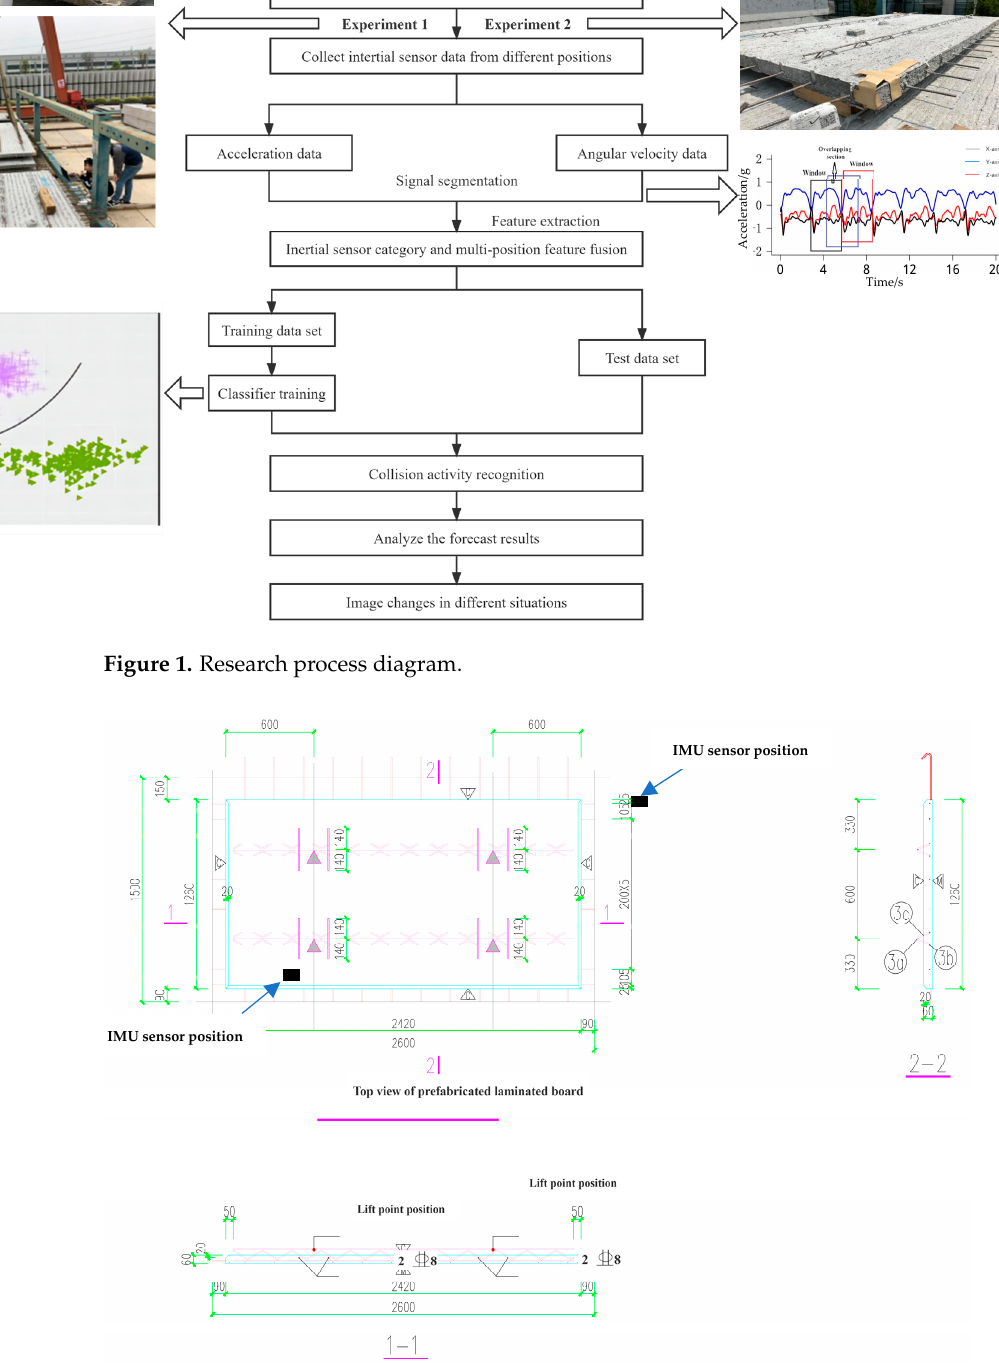
Figure 2. Schematic of prefabricated laminated board and IMU sensor position.